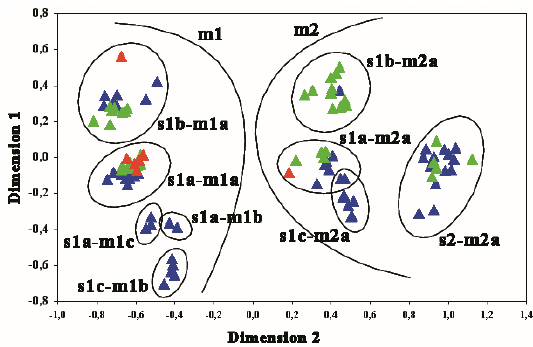
Figure 2. Multidimensional scaling plot of 45 Helicobacter pylori vacA s and m sequences obtained in this study (red: gastric intraepithelial neoplasia, GIN; green: non-neoplastic gastro-duodenal lesions, NNGDLs) and of 55 worldwide Helicobacter pylori sequences from GenBank (blue), based on the vacA gene (both s and m regions). Scaled stress value=0.0208.